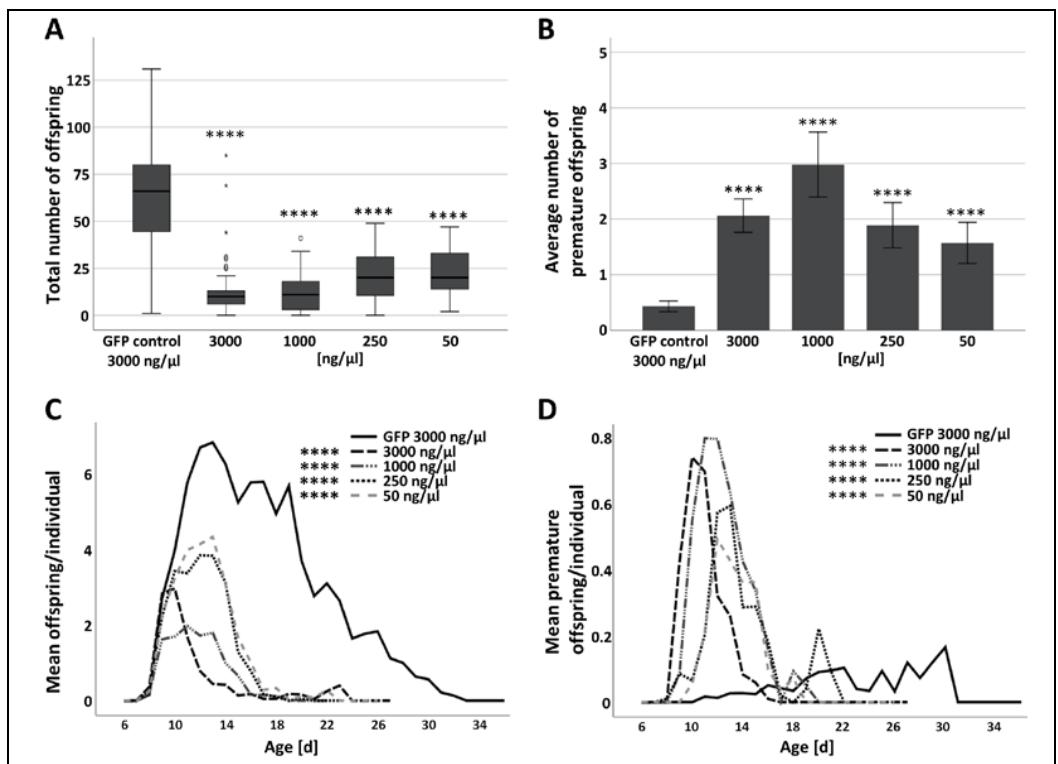
Figure 4. Reproduction parameters following the RNAi-mediated attenuation of p300/CBP in A. pisum . ( A ) The total number of offspring, ( B ) average number of premature offspring, ( C ) number of viable offspring per day and ( D ) number of premature offspring per day were monitored after the injection of 3000-, 1000-, 250- or 50-ng/µL p300/CBP dsRNA. 200 individuals per treatment were injected. To identify significant differences, we used ( A , B ) the Kruskal–Wallis test followed by Bonferroni corrections for pairwise analysis or ( C , D ) two-way ANOVA.